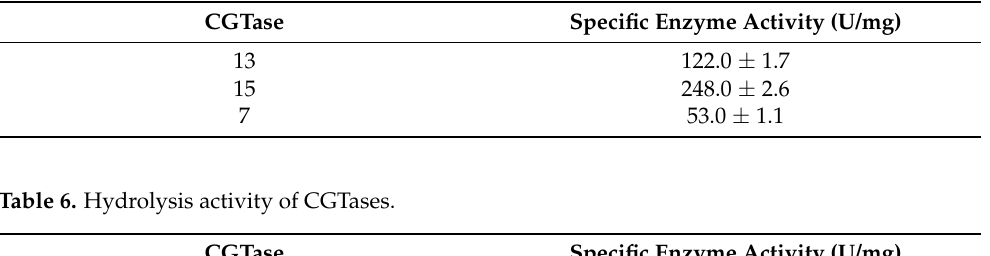
Table 5. Disproportionation activity of CGTases.